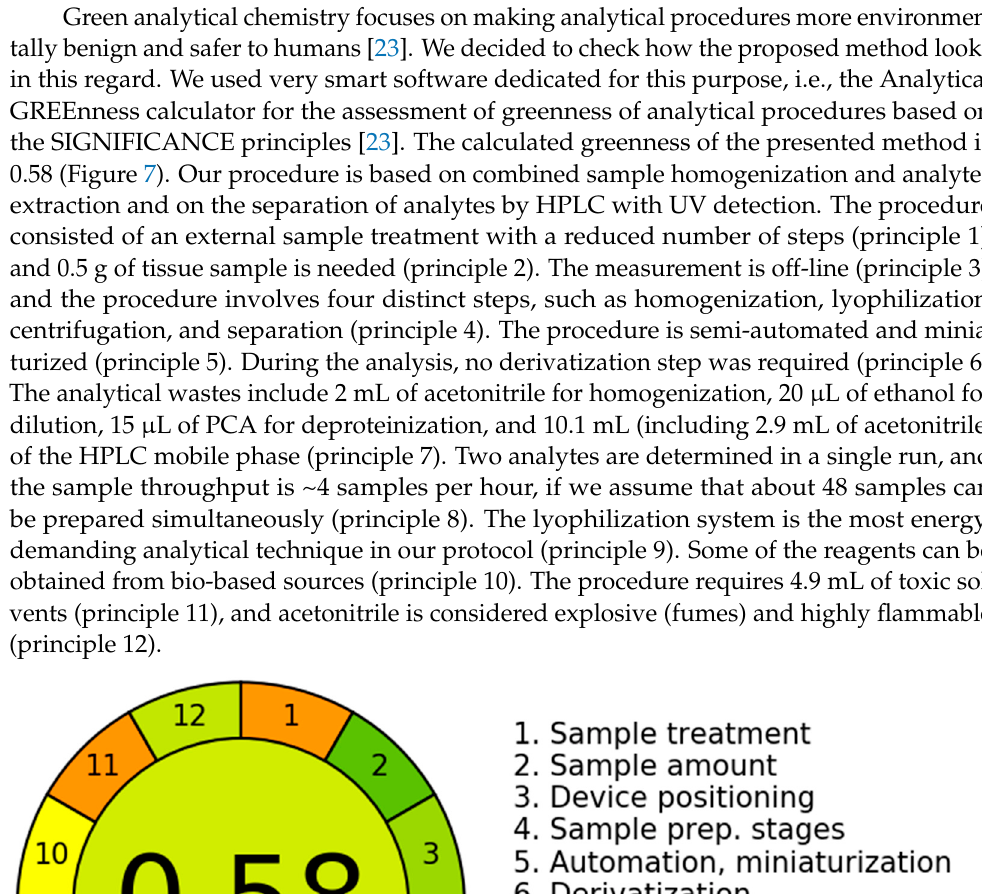
Figure 8. Comparison of greennesses of the methods, from the left [5,8,22]. Our procedure achieved a better score, mainly because it does not use a complicated and multi-step liquid-liquid extraction or SPE. Efforts should continue to be made to im- prove procedures in order to offset their negative impacts on the environment and human health. 4. Conclusions